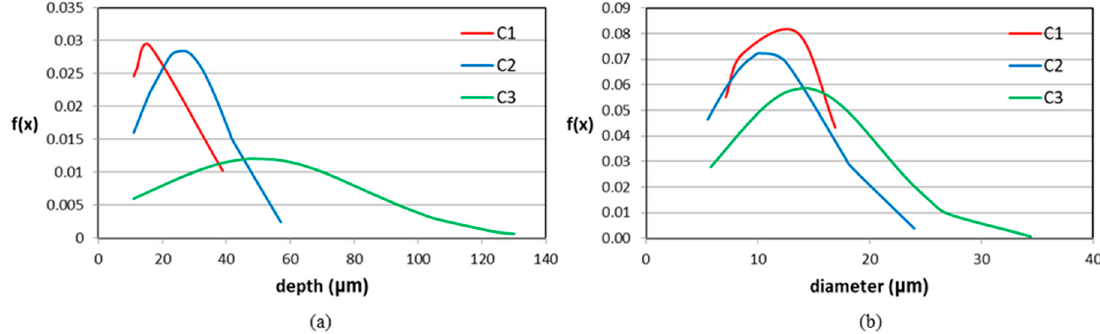
Figure 4. Normal distribution of the depth ( a ) and diameter ( b ) of the pit.